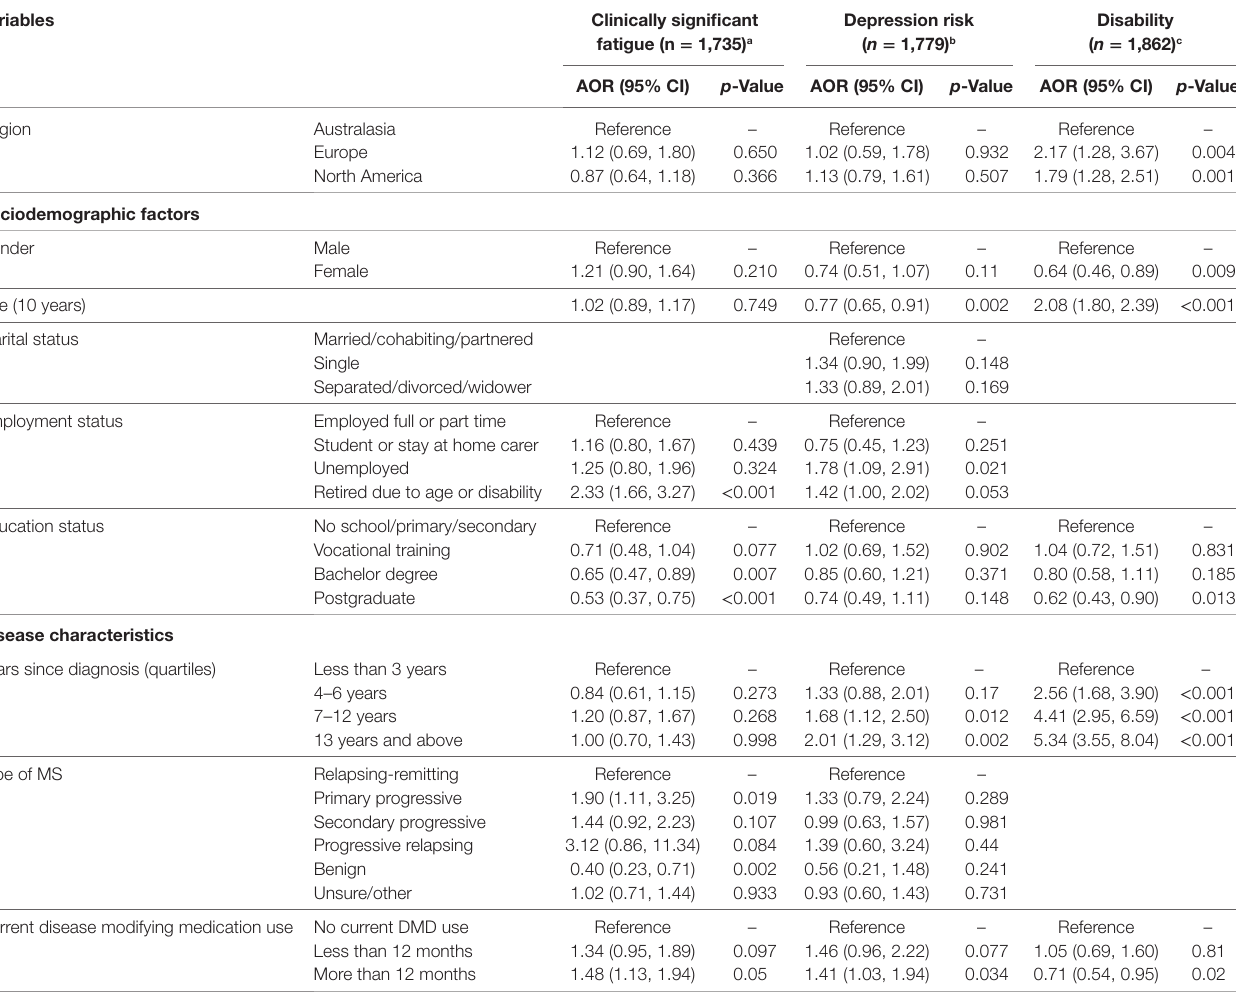
Table 4 | Associations between regions and other covariates with clinically significant fatigue, depression screen, disability obtained using multivariable logistic